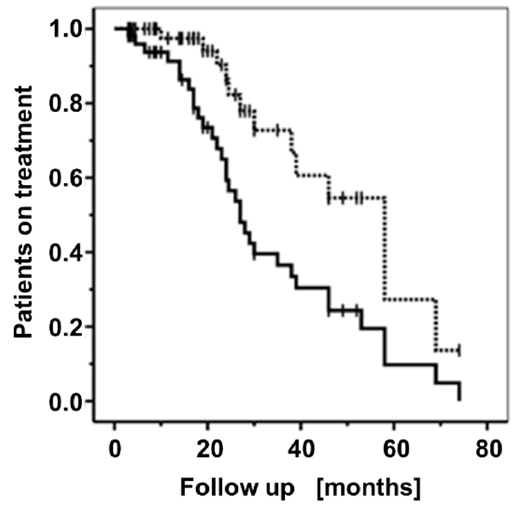
Figure 3. Retention of the treatment. Comparison of the rates of BP patients still receiving MP (solid line) or MTX (dotted line) as a function of time after the onset of the MP plus MTX combination therapy. Short perpendicular bars: censoring events.